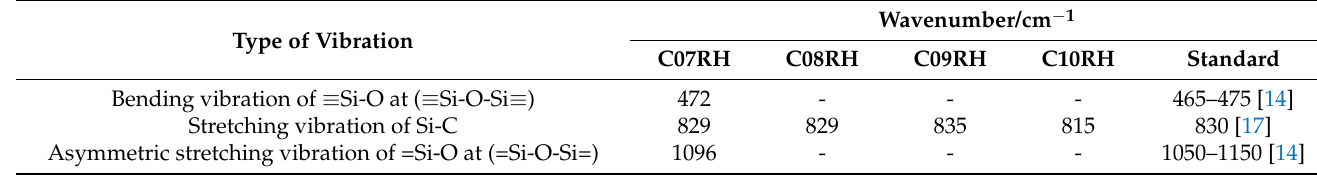
Table 3. Comparison of absorption of product from washing with 1 M